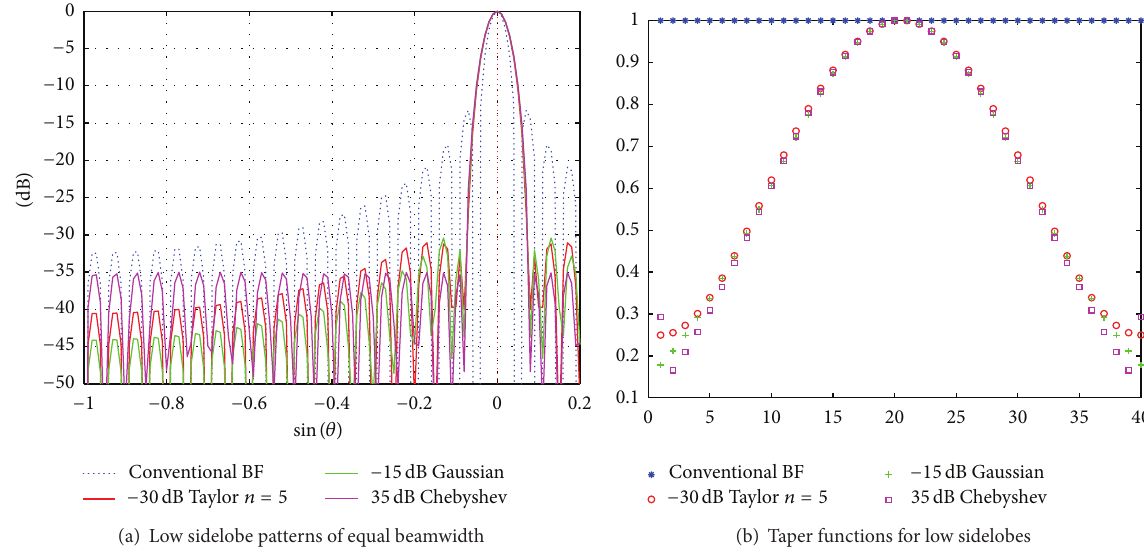
(b) Taper functions for low sidelobes